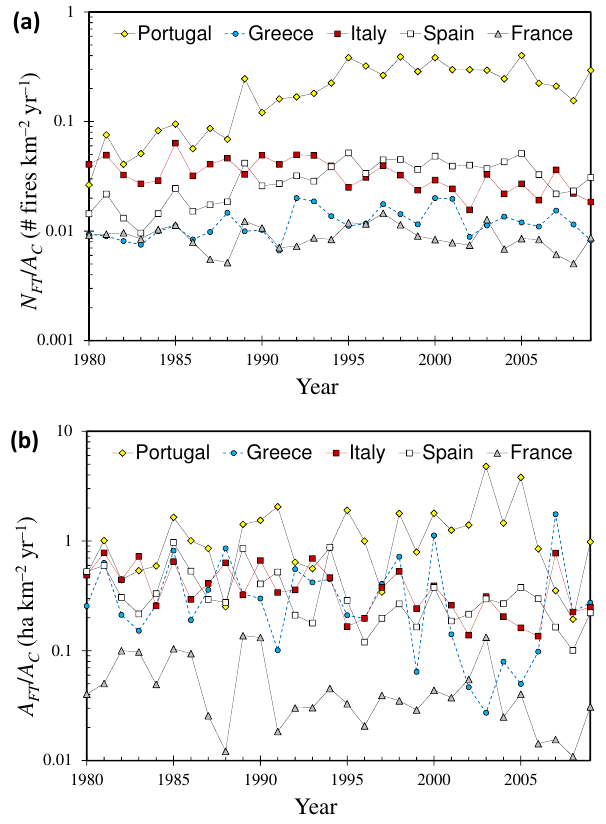
Fig. 1. Rural (wildland) fires in Portugal, Spain, France, Italy and Greece, 1980–2009. For each country, the temporal evolution of (a) fire occurrences density (number of fires per year N FT (#) nor- malized by country area A C (km 2 )) and (b) percentage of country land area burnt by rural fires (burnt area per year A FT (ha) normal- ized by country area (km 2 )) is given. Both y-axes are on log scales. Figure based on data provided in the Annual Reports on Forest Fires in Europe of the European Forest Fire Information System (JRC, 2010). Data does not take into account each country’s different de- grees of completeness in measuring wildfire (“rural” fire) numbers and wildfire areas, both changing over time and depending on ad- ministrative areas within each